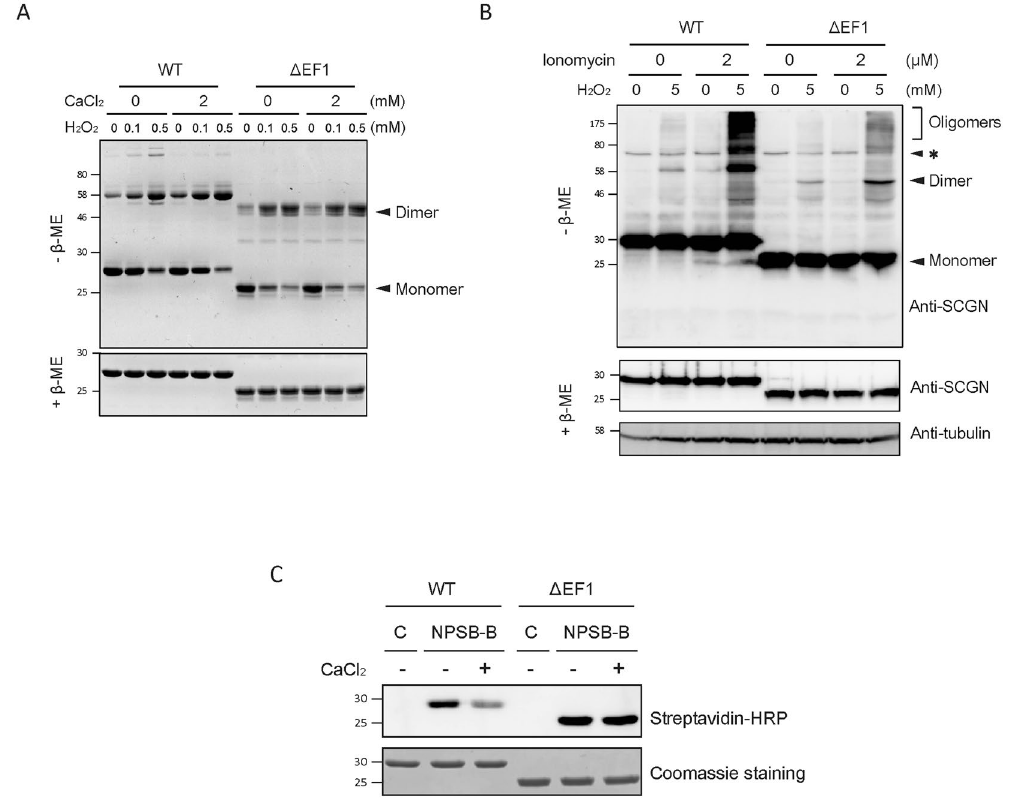
Figure 4. N-terminus of hSCGN is essential for calcium response. ( A ) Purified hSCGN WT and Δ EF1 protein were pre-treated with 0, 2 mM CaCl 2 for 15 min at R.T. and then incubated with the indicated concentrations of H 2 O 2 for 1 h at 37°C. Coomassie blue-stained SDS-PAGE gels under non-reducing ( −β -ME) and reducing ( +β - ME) condition. ( B ) HeLa cells overexpressing hSCGN WT and Δ EF1 were treated with 0 or 2 μ M ionomycin for 5 min and with 0 or 5 mM H 2 O 2 for 30 min at 37 °C. Cell lysates were subjected to Western analysis using anti-hSCGN or anti- α -tubulin antibody. Non-specific bands were indicated as * . ( C ) Recombinant hSCGN WT and Δ EF1 proteins were incubated with 0 or 2 mM CaCl 2 for 15 min, and with 1 mM NPSB-B for 2 h at R.T. Labeled samples in gel sample buffer containing 10 mM NEM were detected with streptavidin-HRP. Full-length gels and blots are in Supplementary Fig.